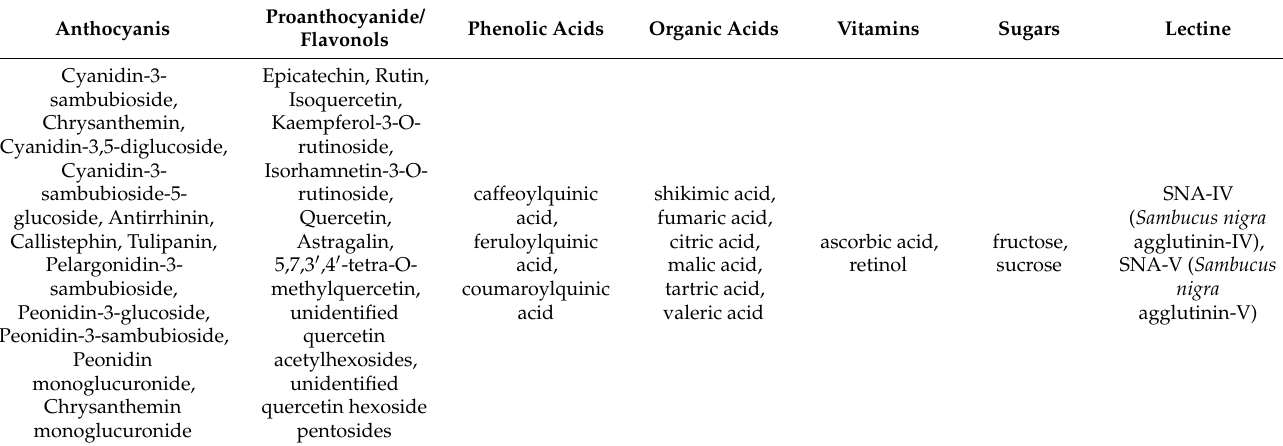
Table 2. Chemical composition of